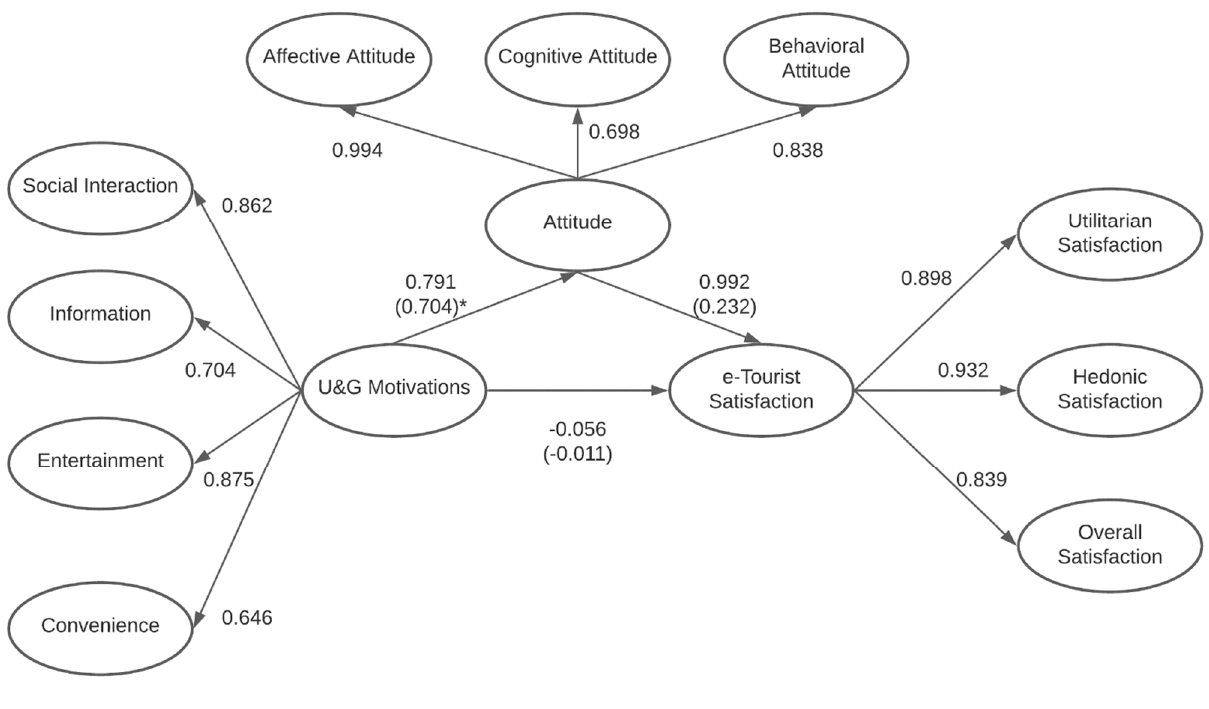
Figure 3. Standardized and Unstandardized Coefficients of the Level 2 SEM. Note: This study also examined the direct relationships between U&G motivations (and sub-factors of U&G